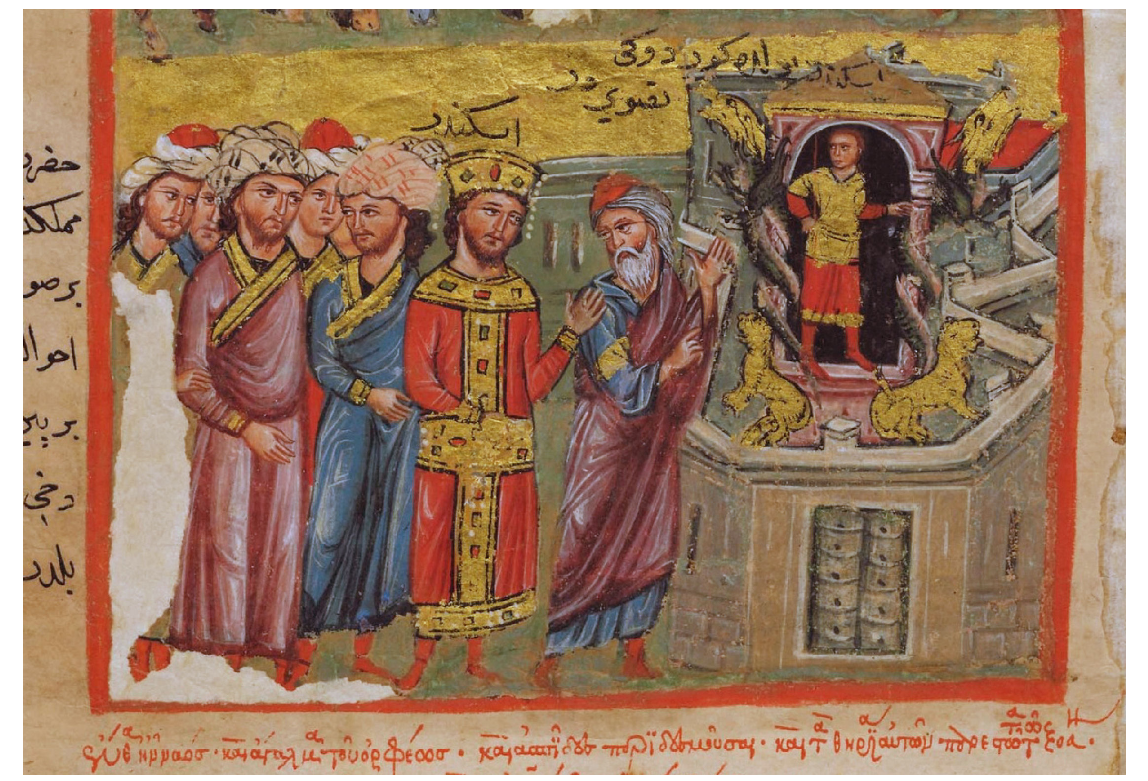
Figure 15. Venice. Istituto Ellenico di Studi Bizantini e Postbizantini cod. 5, fol. 63v (detail). Alexander visits the temple of Orpheus. Photo: ©Istituto Ellenico di Studi Bizantini e Postbizantini, Venice, all rights reserved.